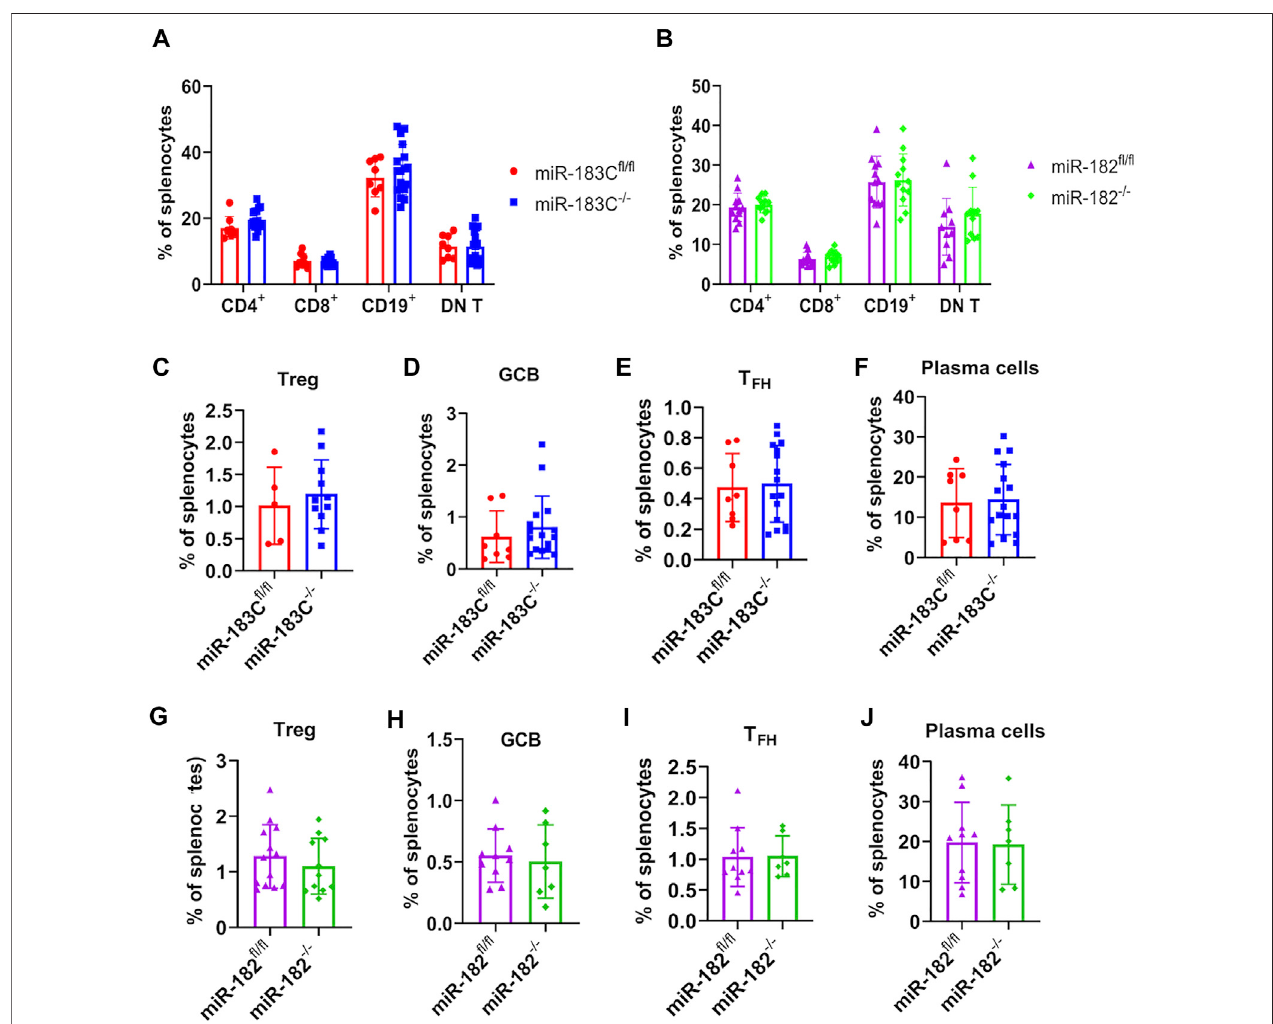
FIGURE 5 | Evaluate the effect of miR-182 and miR-183C deletion on splenic lymphocyte composition in B6/lpr mice. The different lymphocyte subsets in the freshly-isolated splenocytes were analyzed by fl ow cytometry. Please see Supplementary Figure S3 for the gating of different immune cell subsets in the splenocytes. (A,B) Summary data of the frequency of CD4 + T cells, CD8 + T cells, CD19 + cells, and CD3 + B220 + CD4 − CD8 − double negative T cells (DN T cells) in the splenocytes of miR-183C − / − and controlmiR-183C fl / fl B6/lpr (A) , miR-182 − / − and control miR-182 fl / fl B6/lpr (B) . Thegraphsshow means ±SD ( n ≥ 8). (C – J) Summarydata ofthe frequency of differentiated CD4 + CD25 + Foxp3 + (C,G) , CD19 + GL7 + IgD − GCB (D,H) , CD3 + CD4 + CXCR5 + PD1 + T FH (E,I) , CD19 − CD138 + plasma (F,J) cells in the splenocytes ofmiR-183C − / − and miR-183C fl / fl (C – F) , miR-182 − / − and miR-182 fl / fl (G – J). Thegraphsshow means ±SD ( n ≥ 5). Unpaired student t tests wereperformed (miR-183C fl / fl vs . miR-183C − / − , miR-182 fl / fl vs . miR-182 − / − ) for statistical analysis. No signi fi cant differences were observed in the difference immune cell subsets between knockout and control